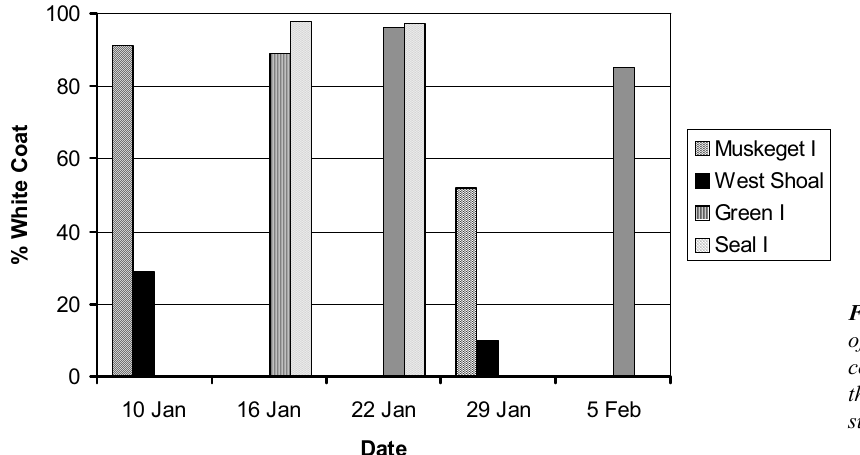
Fig. 2. The average proportion of pups categorized as white coats at the 4 pupping sites off the Northeastern U.S. for each survey